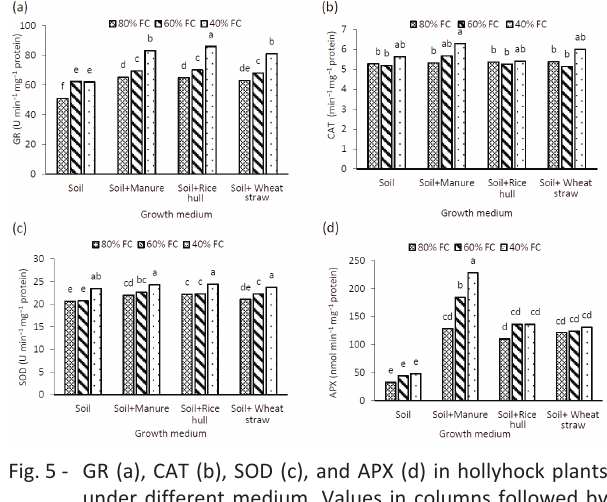
Fig. 5 ­ GR (a), CAT (b), SOD (c), and APX (d) in hollyhock plants under different medium. Values in columns followed by the same letter are not significantly different at the 0.05 level